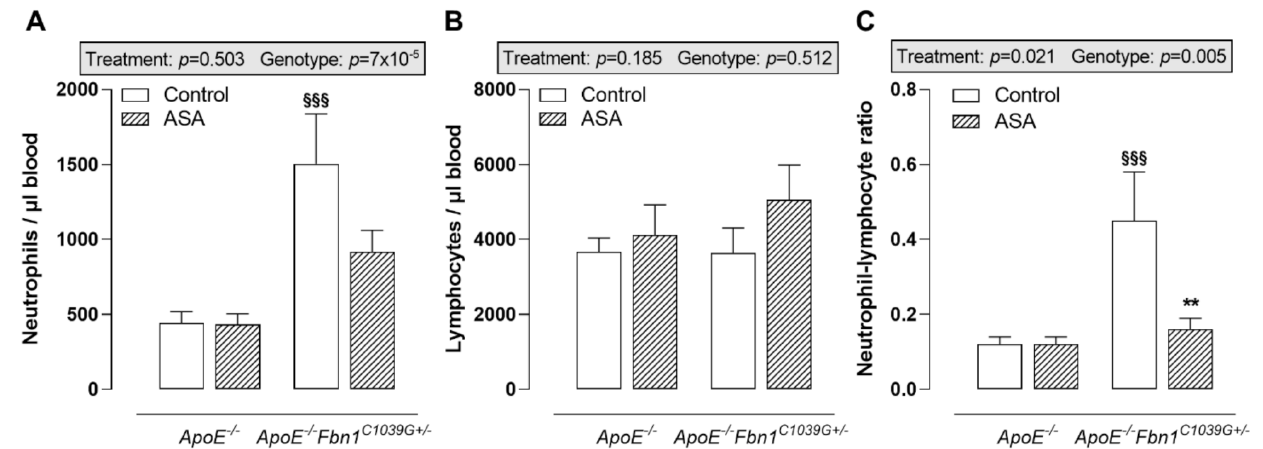
Figure 2. Blood neutrophils and lymphocytes. ( A ) Circulating neutrophils were higher in control ApoE − / − Fbn1 C1039G+/ − mice compared to ApoE − / − mice and were not significantly affected by ASA treatment. ( B ) Absolute numbers of circulating lymphocytes remained equal between all groups of mice. ( C ) As a result of ASA treatment, the neutrophil–lymphocyte ratio was normalised in ApoE − / − Fbn1 C1039G+/ − mice. 2-way ANOVA: §§§ p < 0.001 vs. ApoE − / − control and ** p < 0.01 vs. ApoE − / − Fbn1 C1039G+/ − control. Table 2. Blood immune cell profile. ApoE − / − ApoE − / − Fbn1 C1039G+/ − Main Effect p Values Control ASA Control